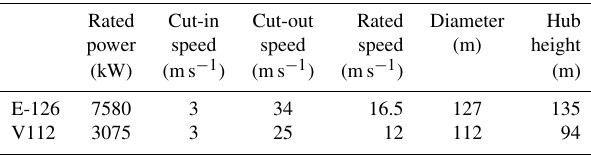
Figure 4. Power curves of the Enercon E-126 and Vestas V112 Onshore turbines. The E-126 turbine still produces energy until its cut-out wind speed of 34ms − 1 . Table 4. Characteristics of the Enercon E-126 and Vestas V112 On- shore wind